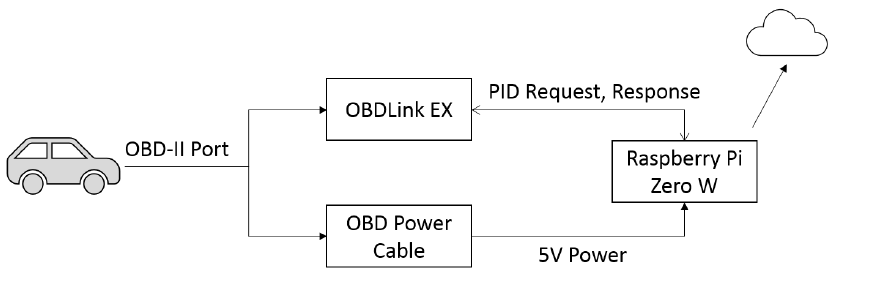
Figure 4. Block diagram of the OBD-II system installed in the Hyundai Ioniq Battery Electric to enable online monitoring of vehicle parameters.